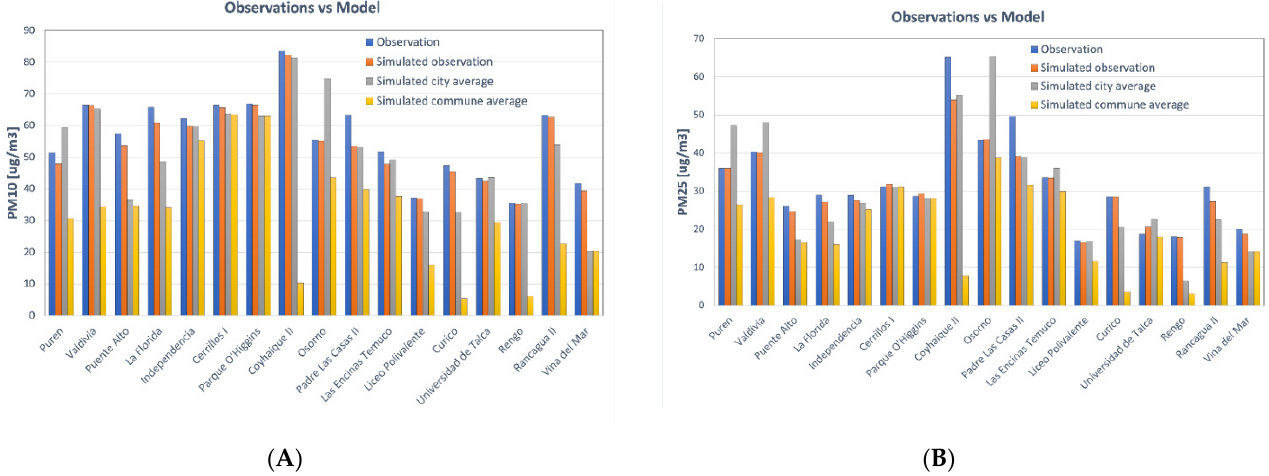
Figure 1. WRF-CHIMERE modeling system to estimate air pollutants. ( A ) Comparison between PM 10 estimations based on model and monitoring based on stations. ( B ) Comparison between PM 2.5 estimations based on model and monitoring based on stations. Yellow: simulated commune yearly average; gray: simulated city yearly average; orange: yearly average of simulated observation (closest point to the station); blue: yearly average of station measurements.